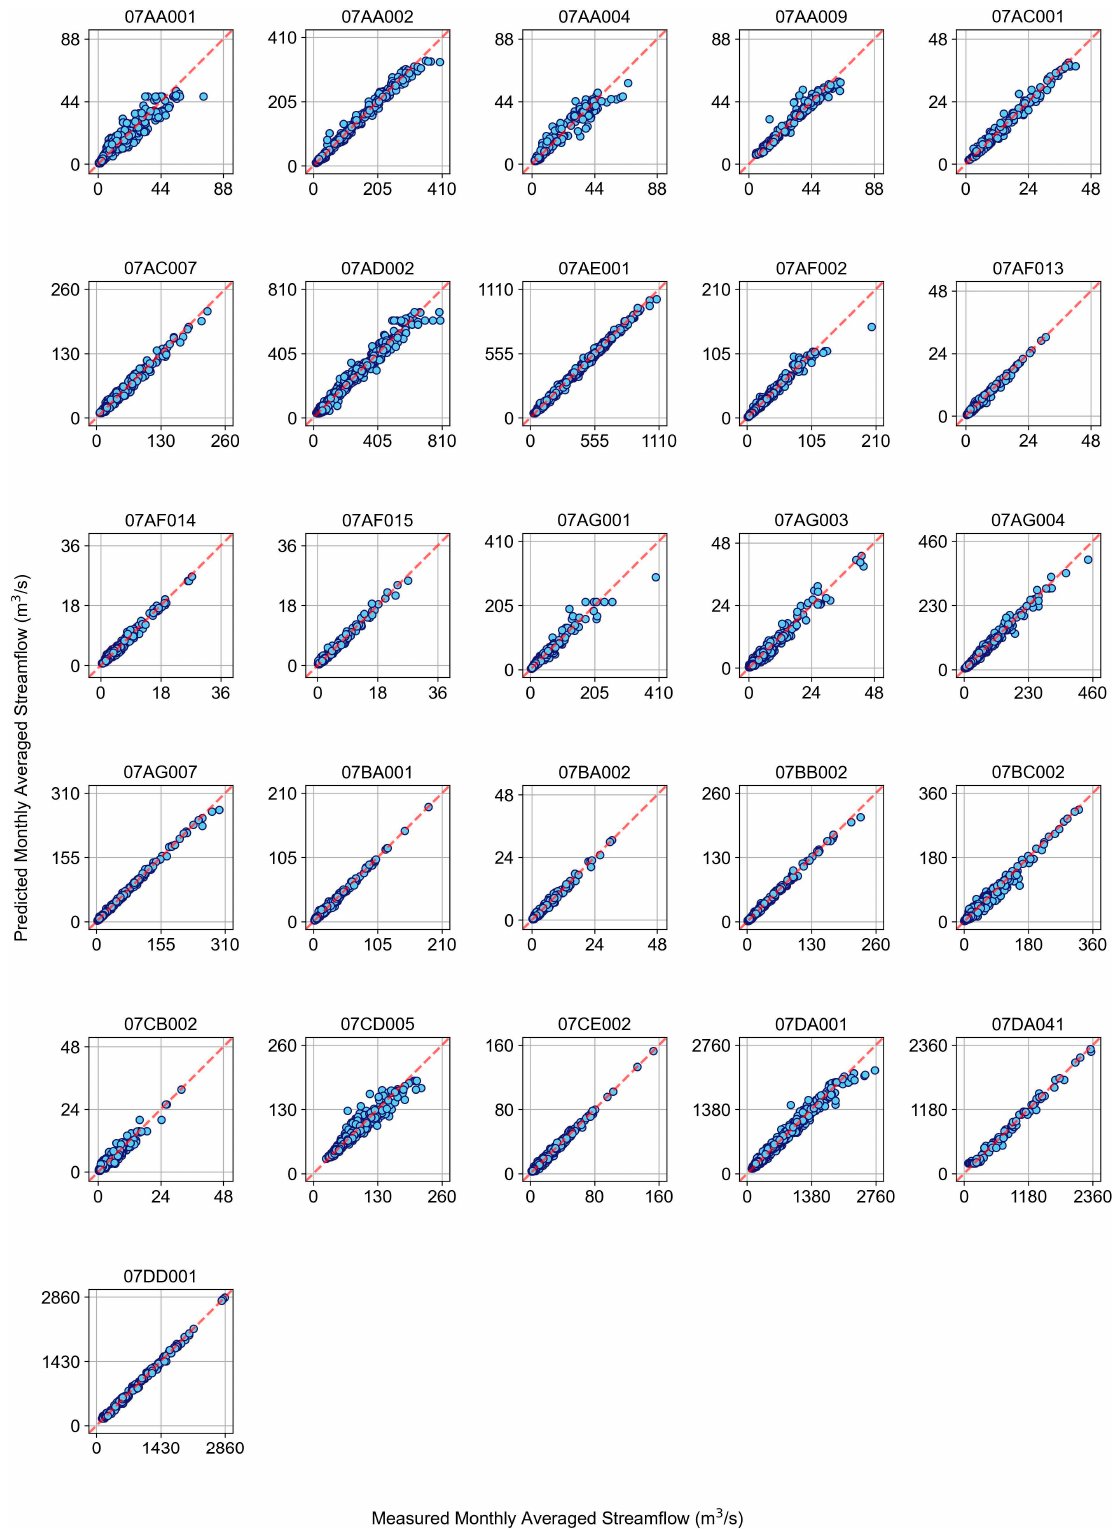
Figure 5. Comparison of measured and predicted monthly streamflow (m 3 /s). The red dashed line represents the perfect prediction (y = x). The closer the blue circles are to this line, the more accurate the predictions.